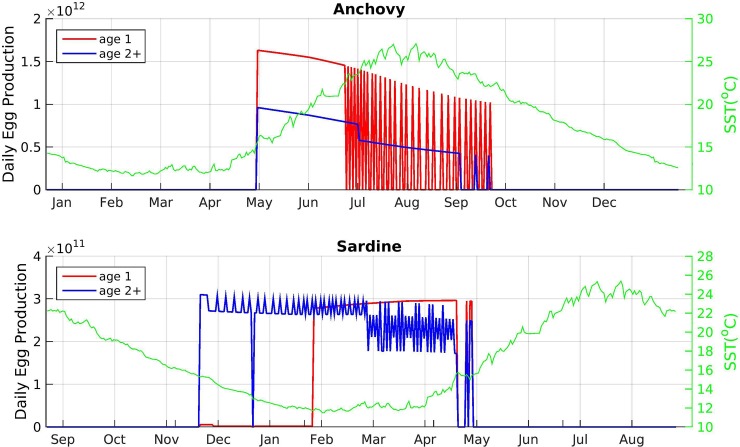
Model-simulated daily egg production (total number of eggs produced by the population) for recruit (age 1) and repeat spawners (age 2+).The seasonal evolution of sea surface temperature (SST) is also shown.